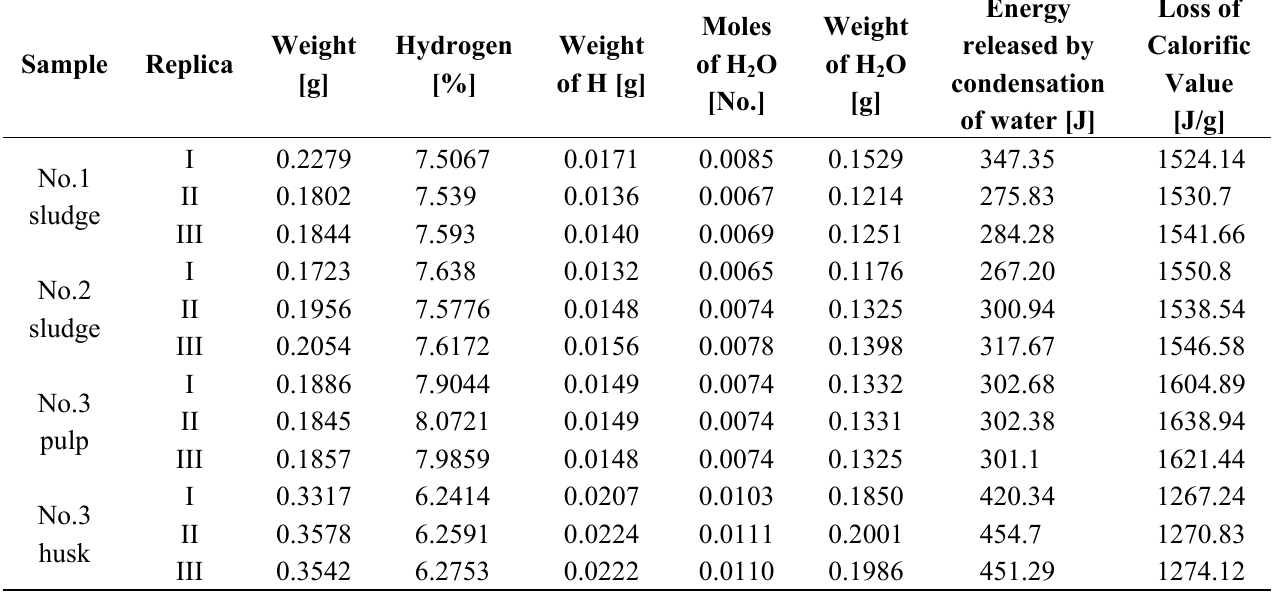
Table 6. Loss of Calorific Value due to presence of intrinsic